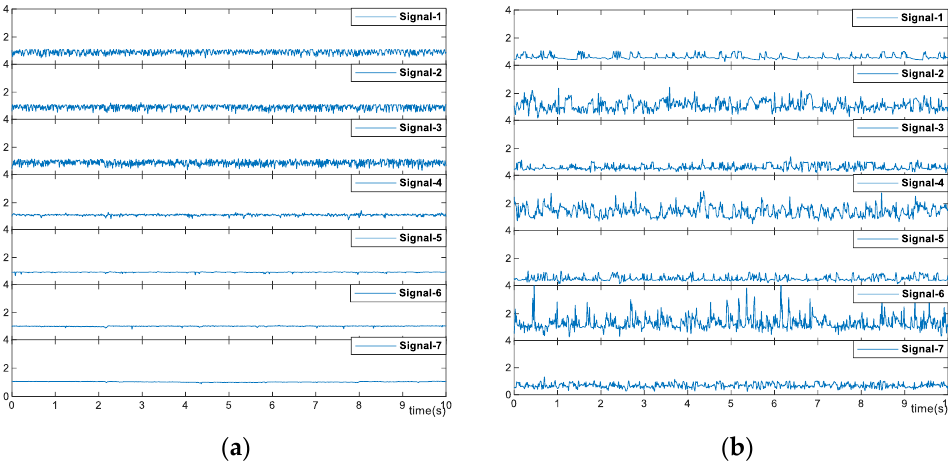
Figure 10. Optical signals of the selected optical fibers with a heating temperature of ( a ) 115 ◦ C and ( b ) 130 ◦ C.